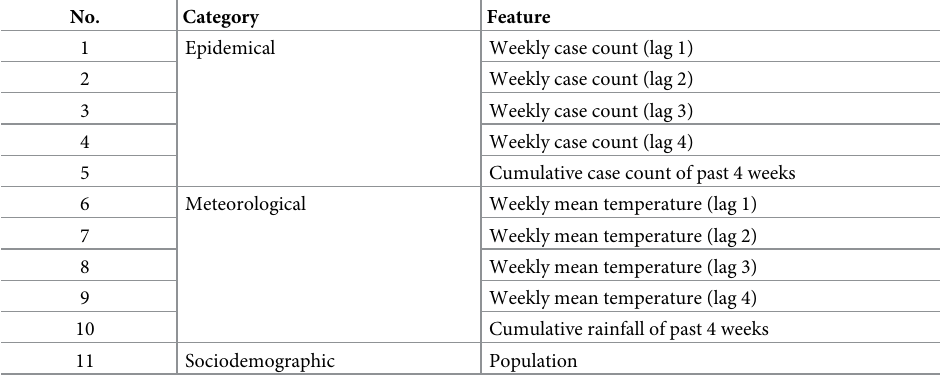
Table 2. Common features extracted for each